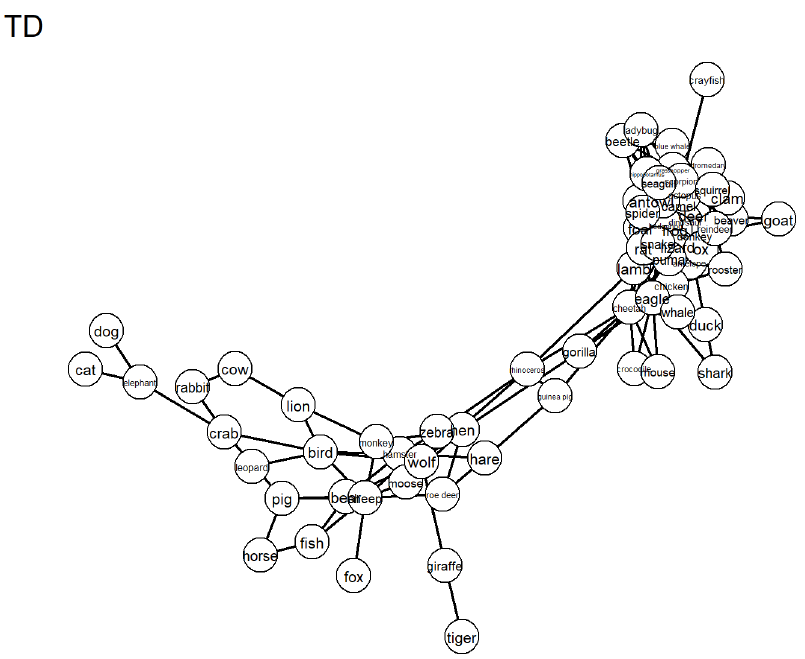
Figure 3. Graphical representation of the semantic network of the children with TD.